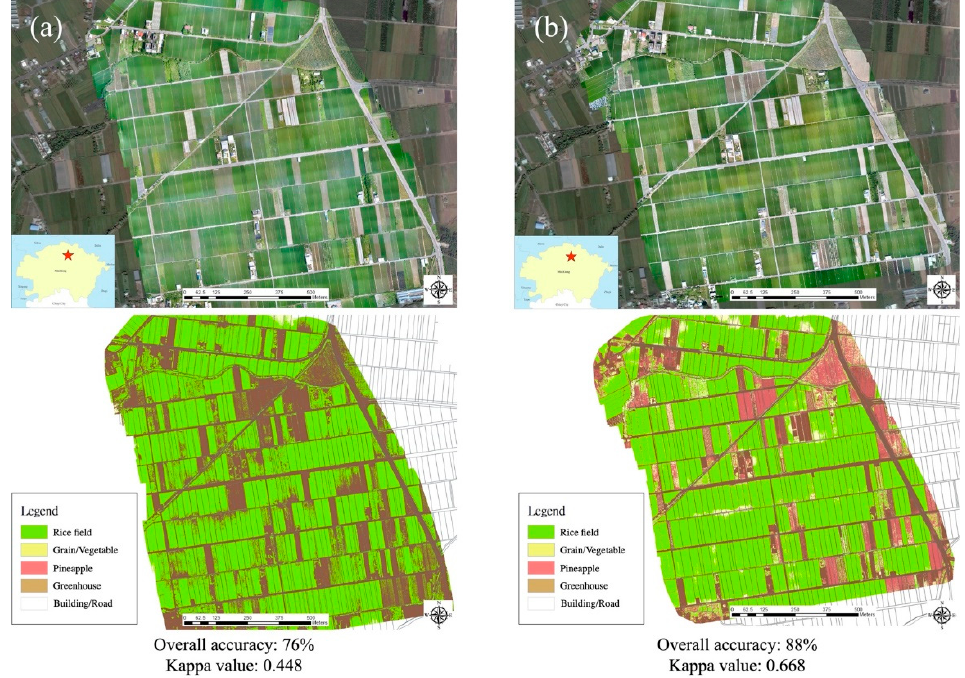
Figure 4. Interpretation accuracy at the Minxiong sampling site. The orthophoto captured on ( a ) 7 ( a ) 7 September 2018; ( b ) 5 October September 2018; ( b ) 5 October 2018.